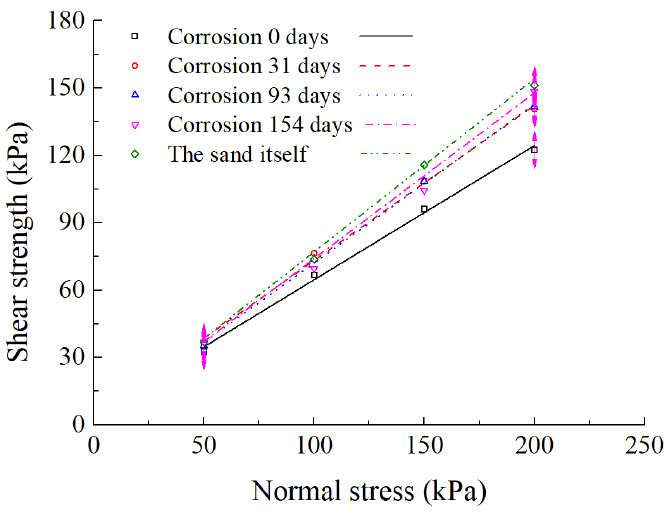
Figure 13. The shear strengths of sand-corroded concrete interfaces and sand itself for different days under different normal stresses.